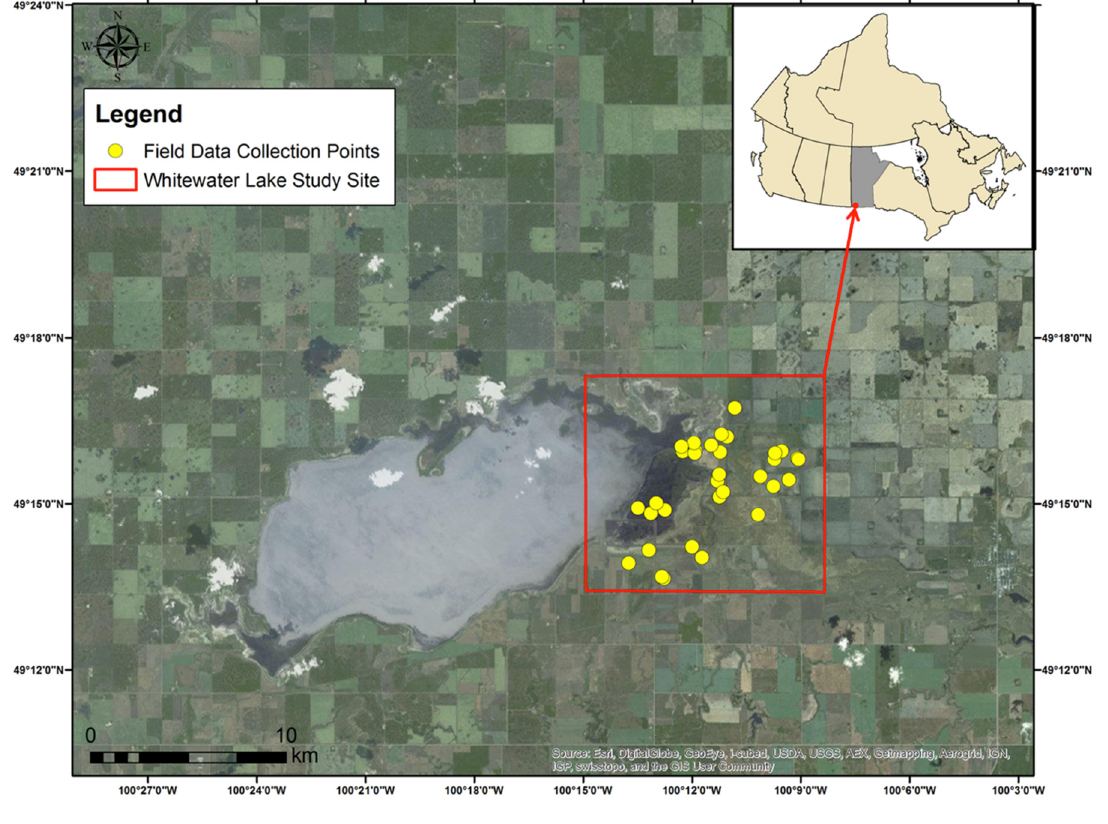
Figure 7. Whitewater Lake, Manitoba. All field data points were collected inside the red